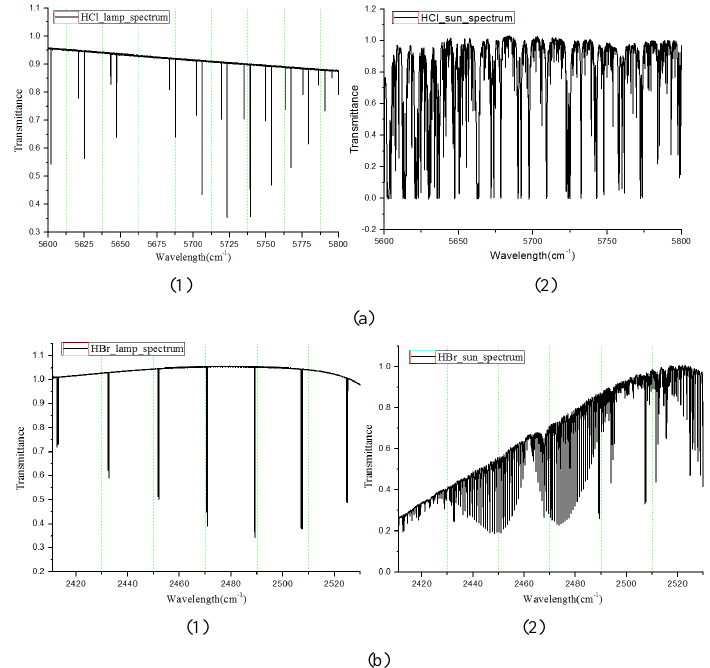
Figure 4. Normalized spectra used for ILS retrievals. Panel (a1) is a lamp spectrum for the TCCON HCl cell measurement, (a2) is a solar spectrum for the TCCON HCl cell measurement, (b1) is a lamp spectrum for the NDACC HBr cell measurement, and (b2) is a solar spectrum for the NDACC HBr cell measurement. Less interfering structures in lamp spectra than solar spectra are shown.